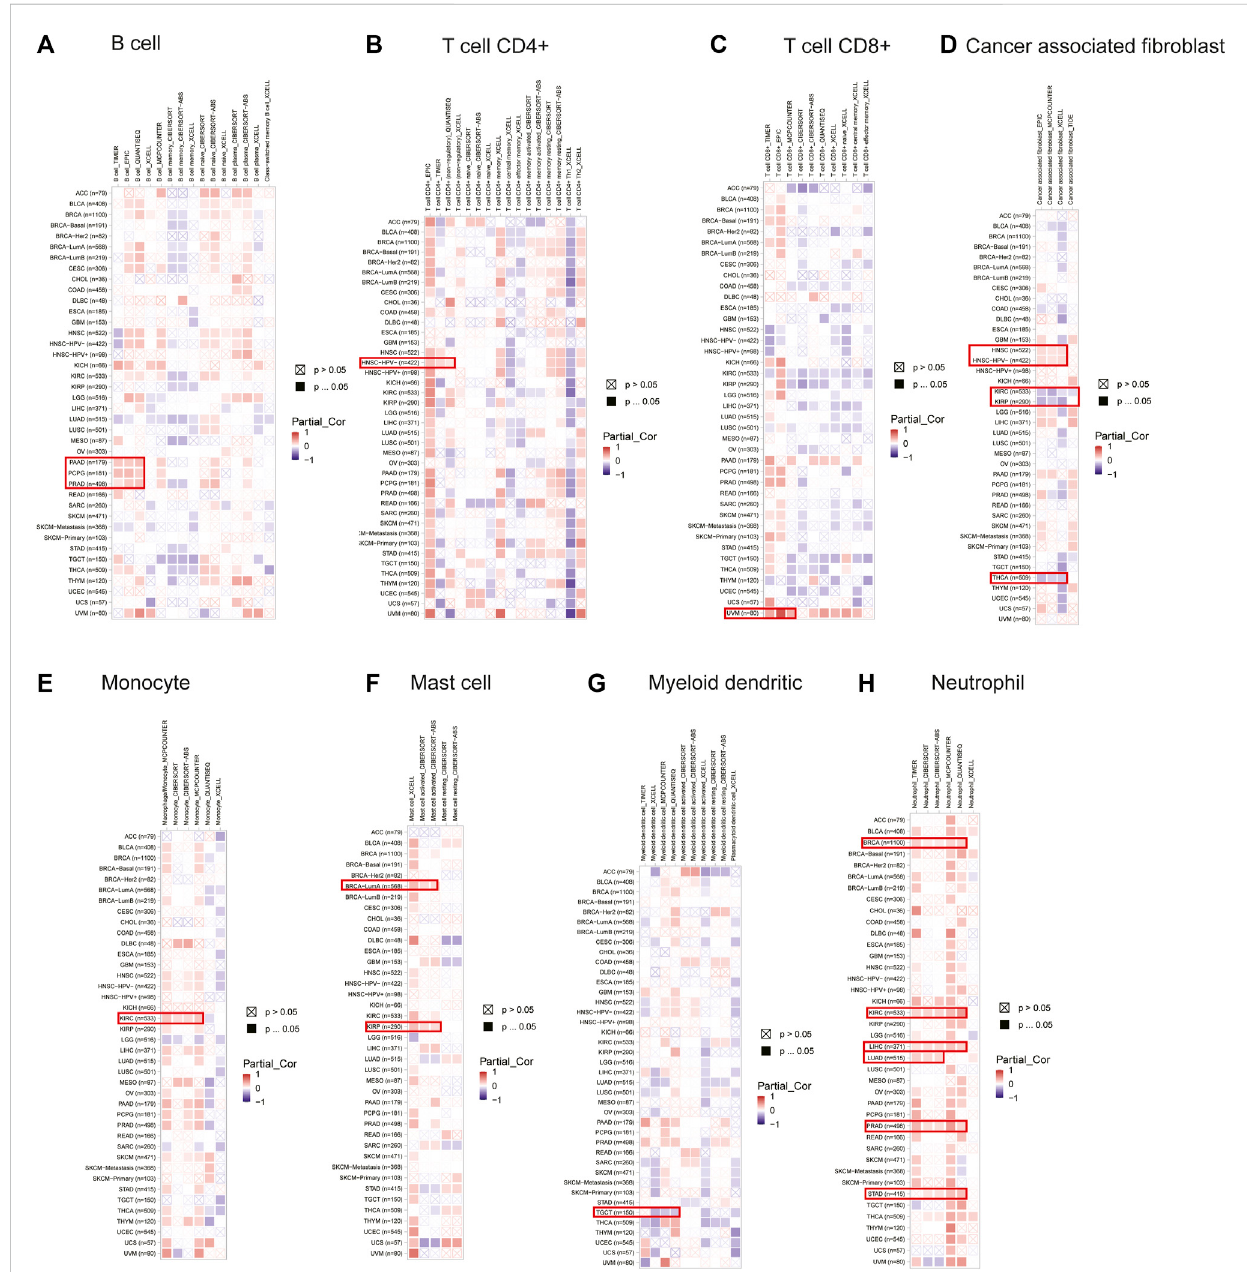
FIGURE 8 Correlationsbetween theexpressionofDLDandimmune cellsindatafromtheTIMER2.0database.The heatmapdepictstherelationships between DLD and the in fi ltration of B cells (A) , CD4 + T cells (B) , CD8 + T cells (C) , cancer-associated fi broblasts (D) , monocytes (E) , mast cells (F) , myeloid dendritic cells (G) and neutrophils (H)